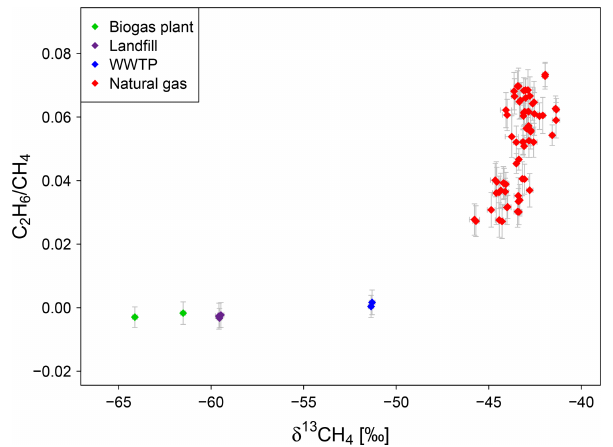
Figure 7. Isotopic signature and C 2 H 6 -to-CH 4 ratio of gas samples from a biogas plant, a landfill, a WWTP and the natural gas dis- tribution system in Heidelberg measured between end of 2016 and November